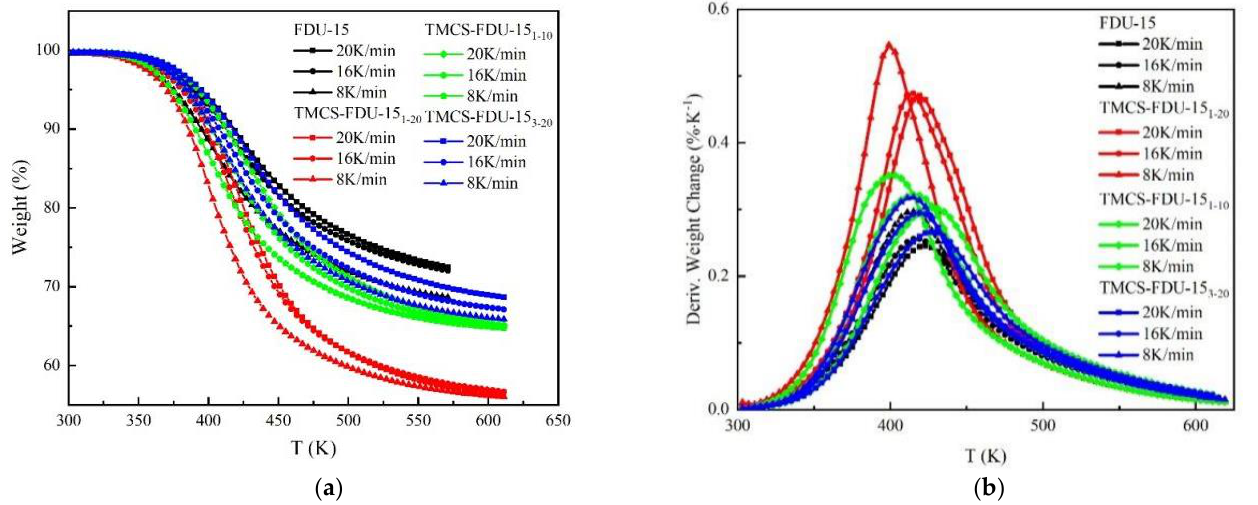
Figure 5. Desorption curve of naphthalene on FDU-15 before and after modification, ( a ) TG curve, and ( b ) DTG curve.